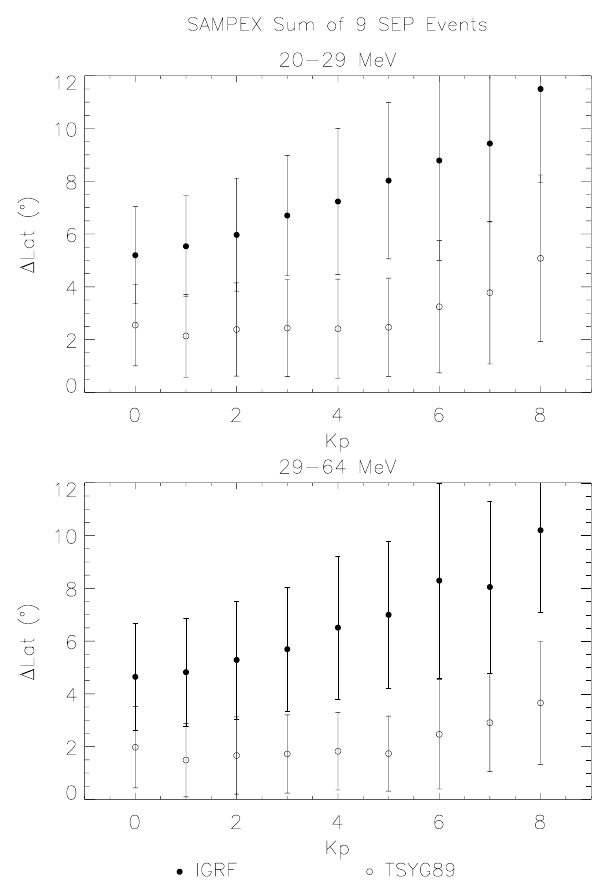
Fig. 5. Top: Comparison of average values of 1 Lat for 20–29MeV protons and for the IGRF model and the Tsyganenko model binned by K p . Bottom: Same as top except for 29–64MeV